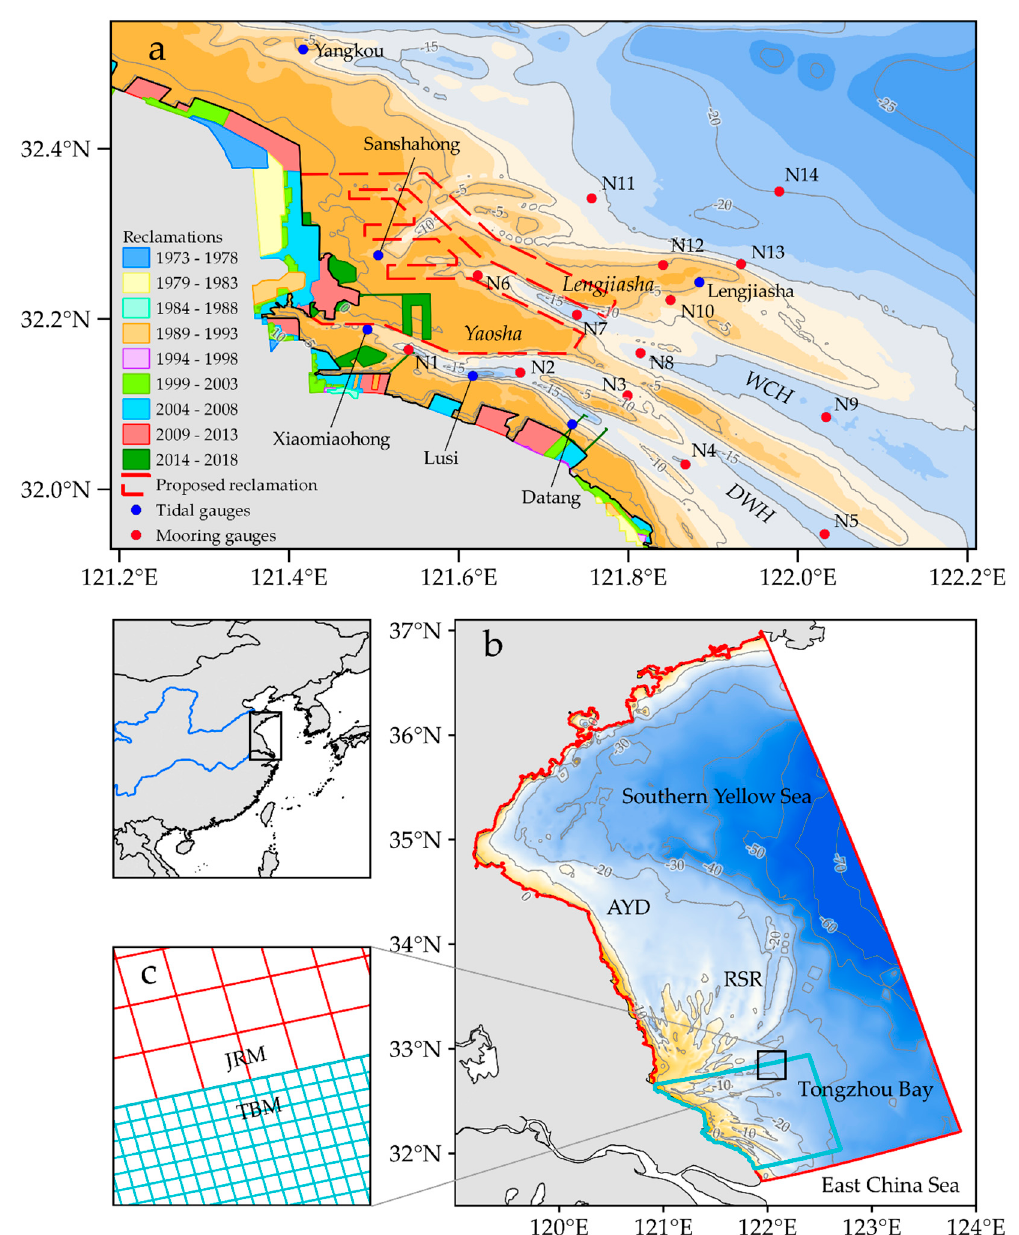
Figure 1. Study area with: ( a ) Regional setting of shoals and channels at Tongzhou Bay situated at the southern Jiangsu coast. Indicated are past reclamation activities, including the outline of the proposed Tongzhou Bay port (red dashed line) [49]. Measurement locations at Tongzhou Bay, where M-stations (blue) are waterlevel gauges and N-stations (red) measured current velocity and direction and sediment concentration among others; ( b ) Computational domains of the Jiangsu Regional Model (red) and Tongzhou Bay Model (blue); ( c ) A close-up of the grid domain shows the coupling and different resolutions between the two “online” coupled grids of the Jiangsu coast (JRM) and Tongzhou Bay (TBM).